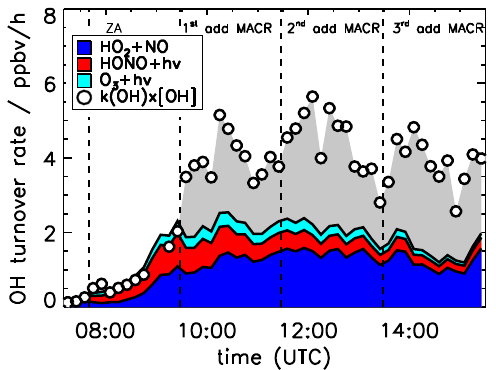
Figure 2. OH budget for the experiment on 11 August 2011. Black circles give the turnover of the OH destruction rate calculated from measured OH concentrations (DOAS) and the measured OH reac- tivity. Coloured areas sum up the OH production from sources that can be calculated from measurements. OH production from the re- action of acyl peroxy radicals with HO 2 is negligible here (see dis- cussion). Because of the short lifetime of OH, the production and destruction rates are expected to be equal at all times. The grey area denotes the difference between calculated destruction and produc- tion rate. Whereas the OH budget is closed before the injection of MACR (“ZA”), on average half of the OH source is missed during MACR oxidation. HO 2 measurements and calculations include a small interference from specific RO 2 (see text for